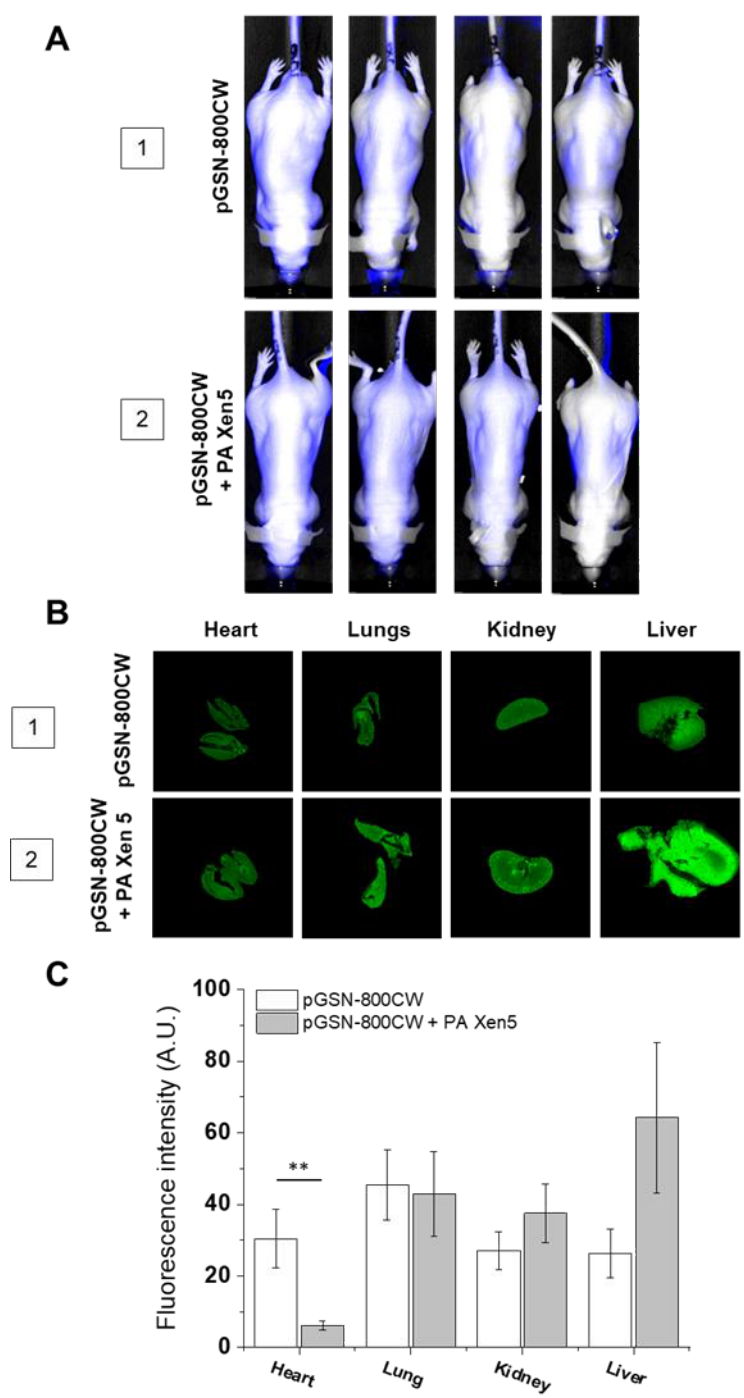
Figure 1. Biodistribution of exogenously administrated pGSN labelled with IRDye ® 800CW (pGSN-800CW) estimated by fluorescence-based analysis of pGSN-800CW-targeted fluorescence signal in Cby.Cg-Foxn1nu / cmdb mice. At the start of the experiment, mice were injected intravenously with sterile saline (healthy mice; group 1) or PA Xen5 inoculum (infected mice; group 2), 8 h later IRDye 800CW-labeled pGSN was added (40 mg / kg) to both groups of animals. After sacrificing the animals (24 h after injection of pGSN-800CW), the hearts, lung, kidney and livers were collected and fluorescence signal was registered at 800 nm channel. Whole mouse scans representing distribution of labeled plasma gelsolin were performed upon the injection of pGSN-800 CW (40 mg/kg) into healthy (group 1) and PA Xen5-infected animals (group 2). Data were collected after 0.5, 4, 8 and 24h from starting of observation. Results from representative animals are shown ( A ). Representative scans of organs collected from sacrificed healthy (group 1) and Pa Xen5-infected animals (group 2) ( B ).